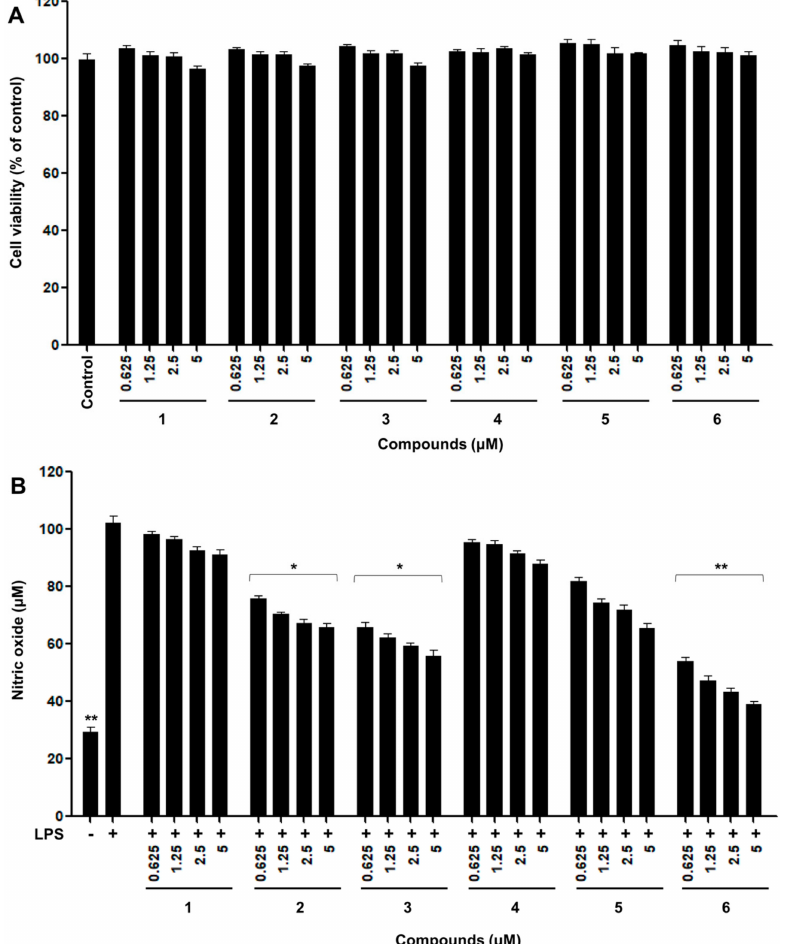
Figure 4. Effects of the isolated compounds 2 – 6 of rotenone on LPS-induced RAW 264.7 cells. ( A ) Cell viability detection by MTT assay in RAW 264.7 cells after treatment with isolated compounds for 24 h. ( B ) The cells were treated with compounds for 2 h, followed by treatment with the LPS (0.1 µ g/mL) for 24 h. The nitrite content of culture media was analyzed. The cells non-treated with isolated compounds and LPS are referred to as the control group. The experiments were conducted in triplicate and the data are expressed as mean ± SD. * p < 0.05 or ** p < 0.01 as compared to the LPS-induced group. 1 : rotenone, 2 : ( − )-rotenolone, 3 : (+)-epirotenolone, 4 : (+)-epirotenone, 5 : dehydrorotenone, 6 : ( − )-tubaic